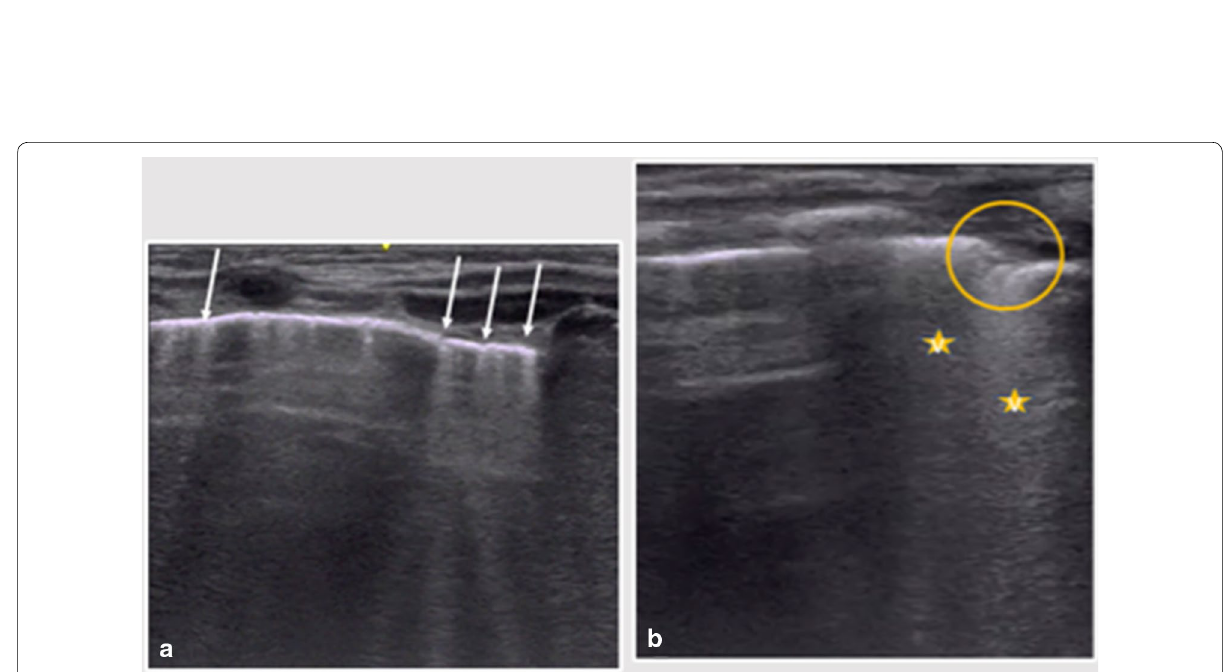
Fig. 2 Two‑week‑old male full‑term newborn with fever and mild respiratory symptoms. Lung US showed multiple vertical B‑lines on all the lung fields bilaterally (arrows in a ). Coalescent B‑lines could be seen on the posterior and inferior lung fields (stars in b ), as well as an irregularity of the pleural line and a tiny subpleural consolidation (circle in b